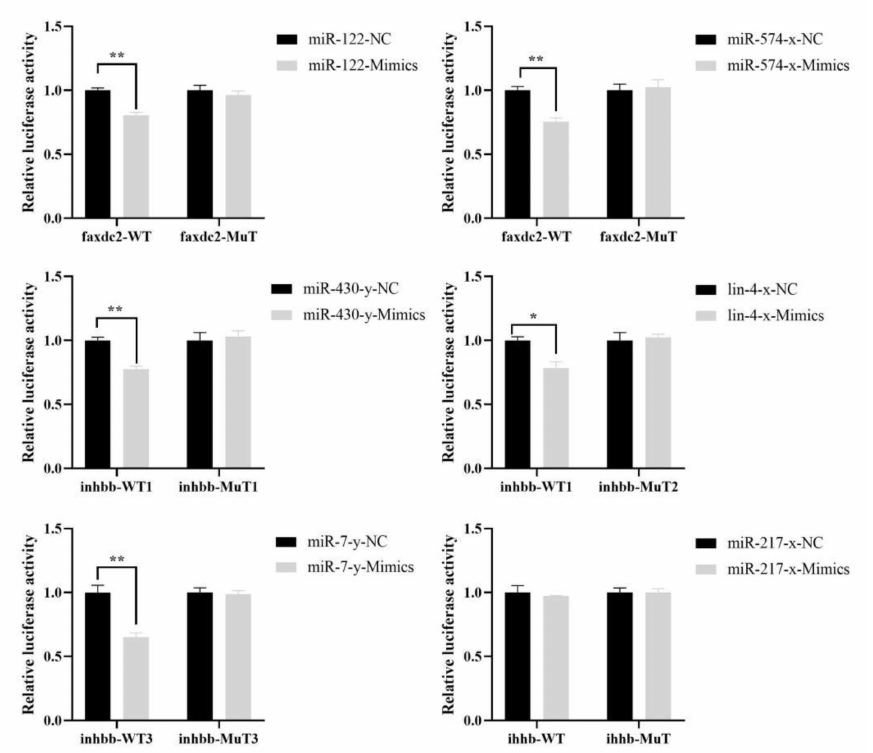
Figure 6. MiRNAs inversely modulated the luciferase activity of plasmids containing wt 3 (cid:48) -UTR of faxdc2 , inhbb , and ihhb . Relative luciferase activity was measured and normalized by Renilla luciferase activity. * p < 0.05; ** p <